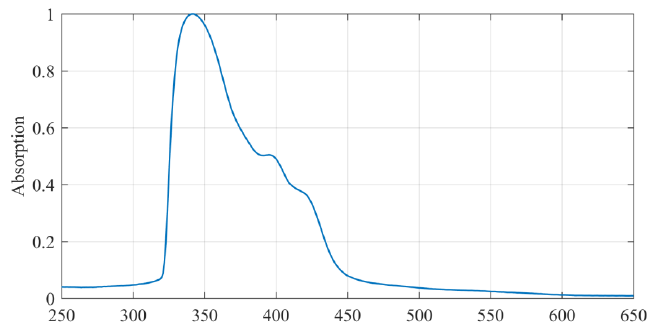
Figure 2. Absorption spectrum of SX AR-P 3500/6 photoresist. Spectra of the standard positive photoresists are available on Allresist’s page [41].